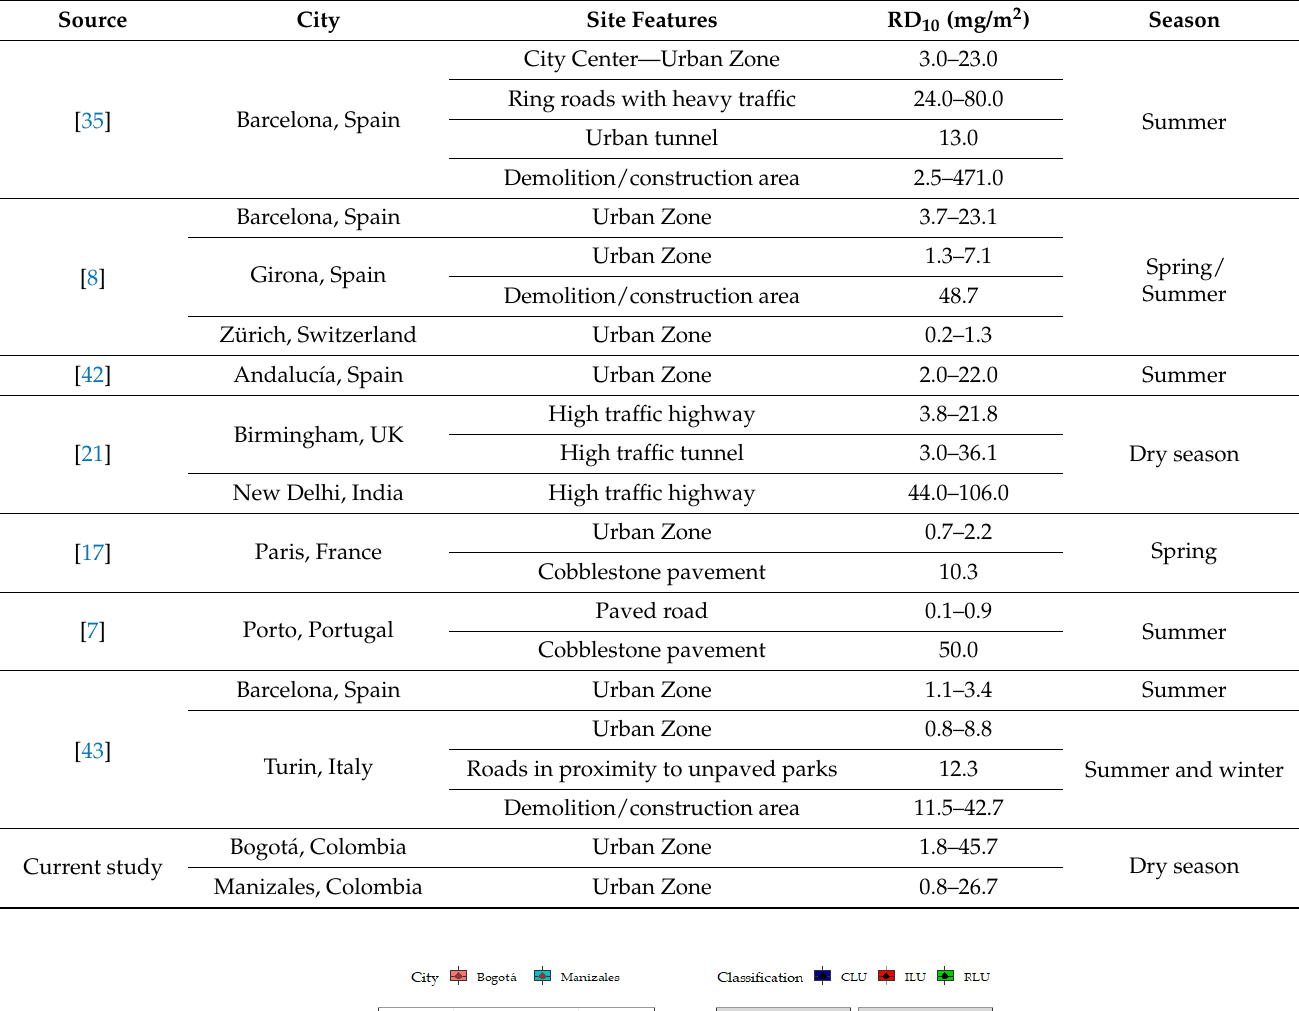
Table 2. Comparison of road dust loads from this study and others reported for different regions. Source